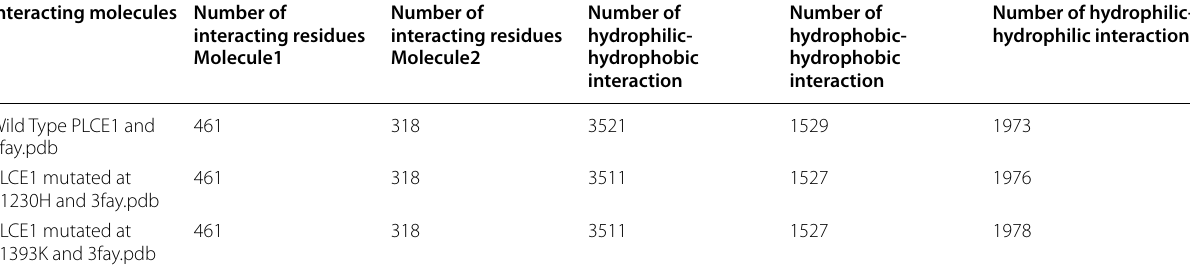
Table 12 The results of interaction prediction of wild type and mutant forms of PLCE1 with IQGAP1 Interacting molecules Number of interacting residues